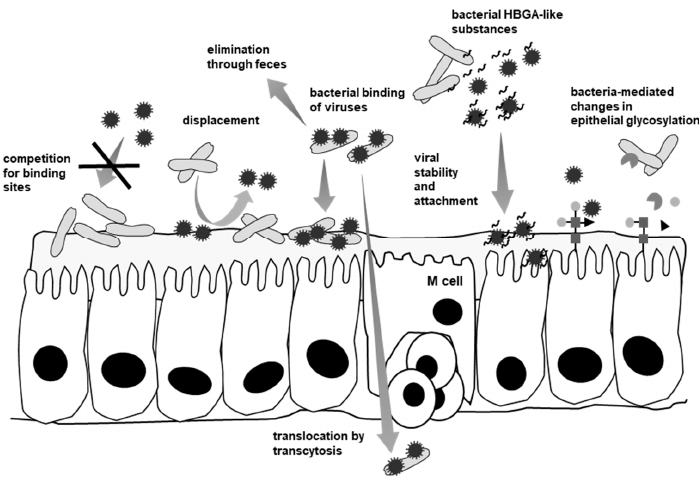
Figure 2. Proposed interactions of commensal intestinal bacteria with enteric viruses and their effects on viral accessibility and attachment to target cells. Physical interactions of bacteria with enteric viruses can promote or block viral infectivity. The binding of viral particles by bacteria can promote their elimination in the feces, stimulate their attachment to the mucosa or their transcytosis. Alternatively, bacteria can block viral binding sites or modify the glycosylation state of the mucosa, which in turn affects viral attachment. Bacterial components released to the lumen (lipopolysaccharide (LPS) or HBGA-like carbohydrates) have been found to stabilize the virions and enhance their attachment to